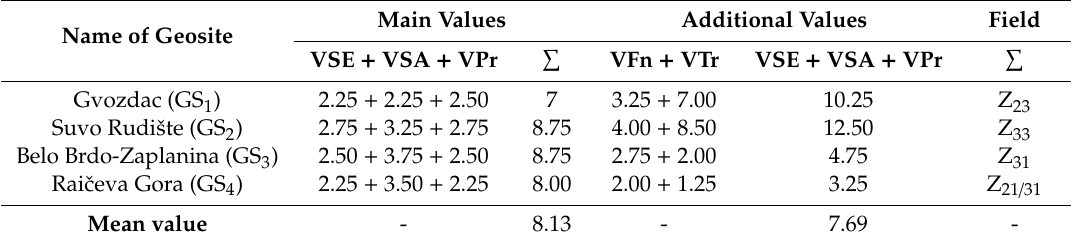
Table 4. Overall evaluation of the analyzed geosites using the Geosite Assessment Model